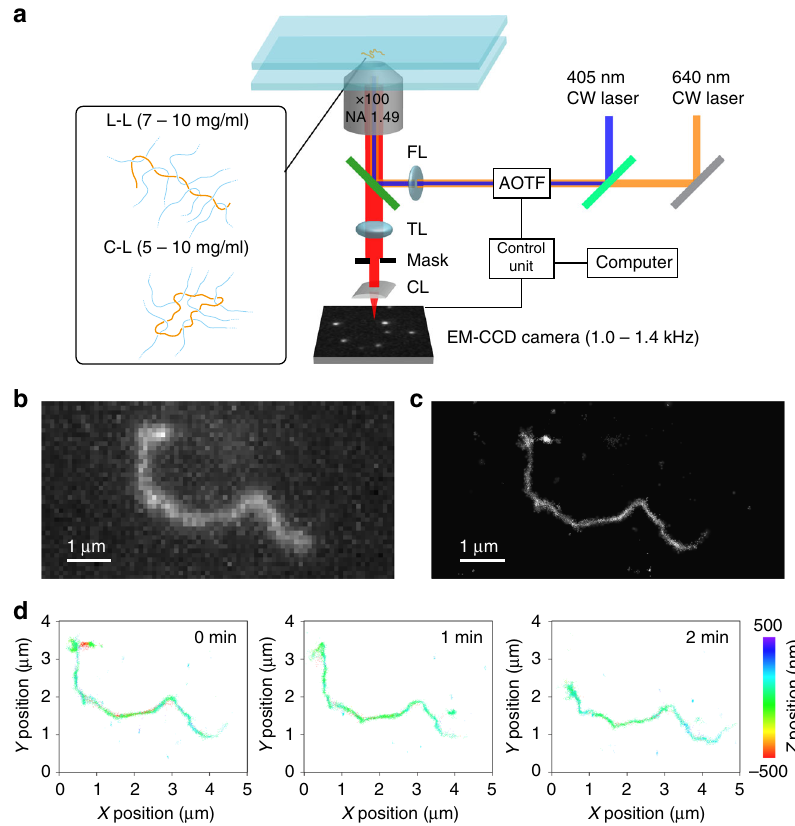
Fig. 2 Time-lapse 3D super-resolution fl uorescence imaging of entangled lambda DNA. a Schematic illustration describing the experimental con fi guration. AOTF acousto-optic tunable fi lter, FL focusing lens, FC focus correction system, TL tube lens, CL cylindrical lens. b Conventional fl uorescence image of Cy5-labelled lambda DNA in an aqueous solution containing 10 mg ml − 1 concentration of non-labelled lambda DNA. c 2D projected super-resolution fl uorescence image of the DNA molecule displayed in b . The super-resolution image was reconstructed from 10,000 frames of images captured at 1 kHz frame rate. d Time-lapse 3D super-resolution fl uorescence images. Each super-resolution image was reconstructed from 10,000 frames of images captured at 1 kHz frame rate. The time-lapse super-resolution fl uorescence images were obtained by recording the 10,000 frames of images every 1 min. The colour bar shows the axial position of the localised